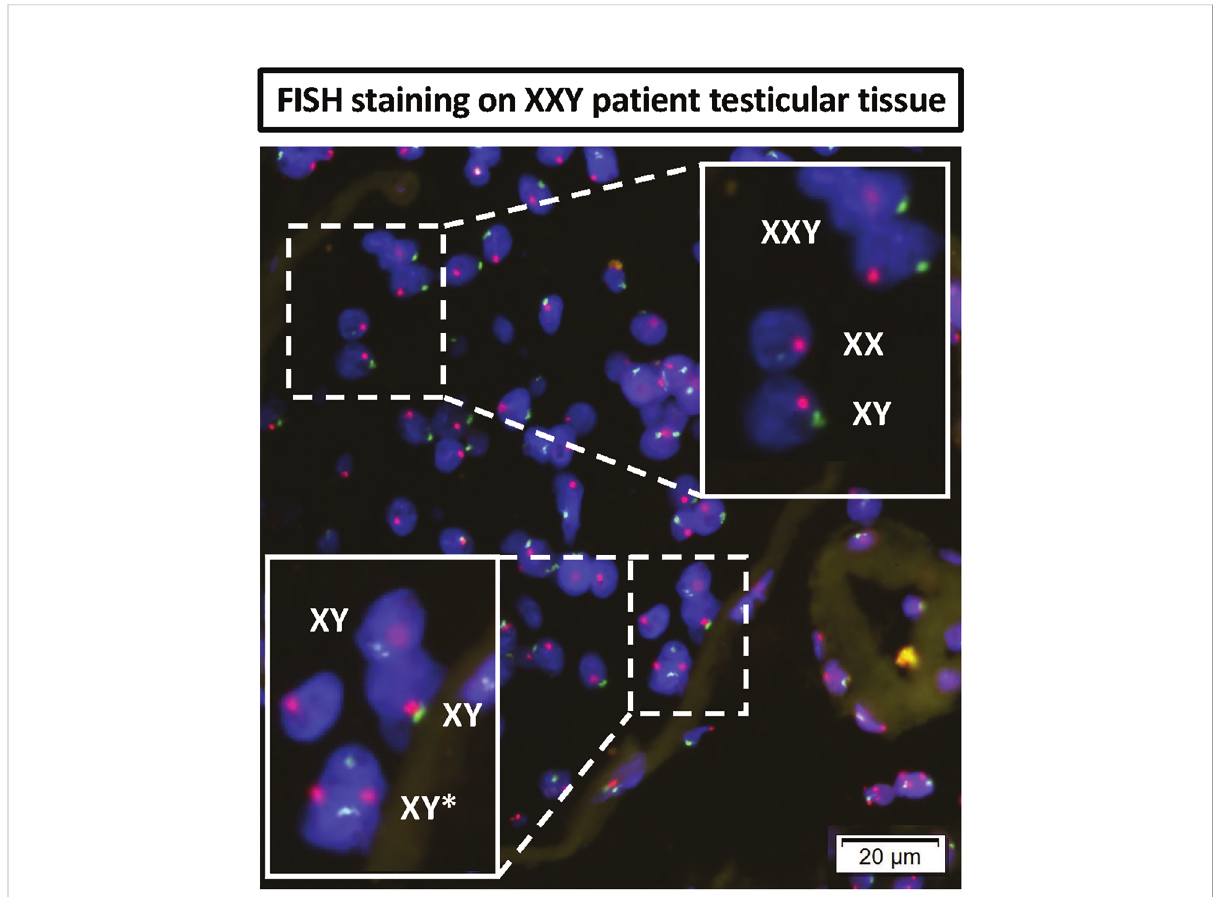
FIGURE 10 DNA FISH analyses of KS testicular tissue was used to assess any mosaicism in KS testes: X (red probe) and Y (green probe) chromosomes. The top magni fi ed region showed all three XXY, XY and XX cells in non-mosaic KS subject. The bottom magni fi ed region shows an XY cell actively dividing in the basal membrane of seminiferous tubules of non-mosaic KS